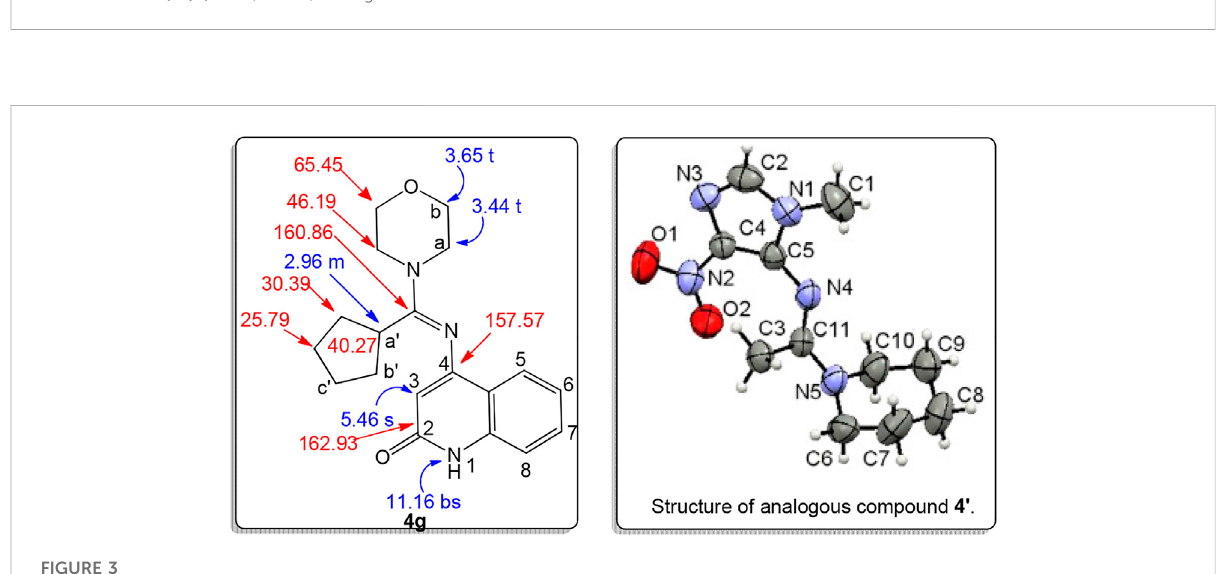
FIGURE 3 Structure of compound 4g